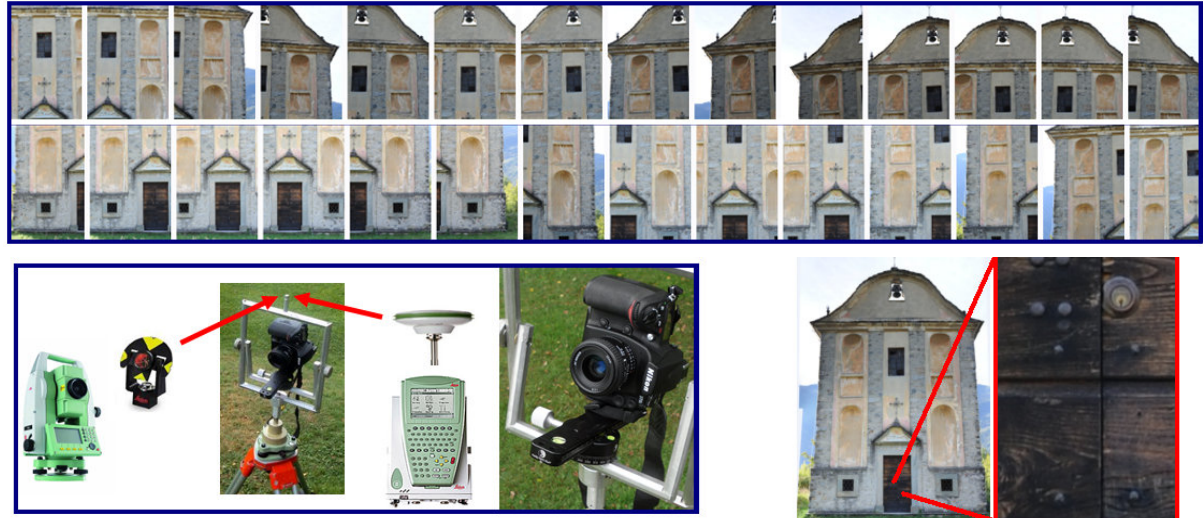
Fig. 3. In the upper rows the images (#28) used to create a high resolution mosaic of an ancient church in Tresivio (Valtellina, Italy). In the lower row, from left to right, the calibrated head for image acquisition and the global image (6512×8900 pix) with a zoom showing the achieved level of